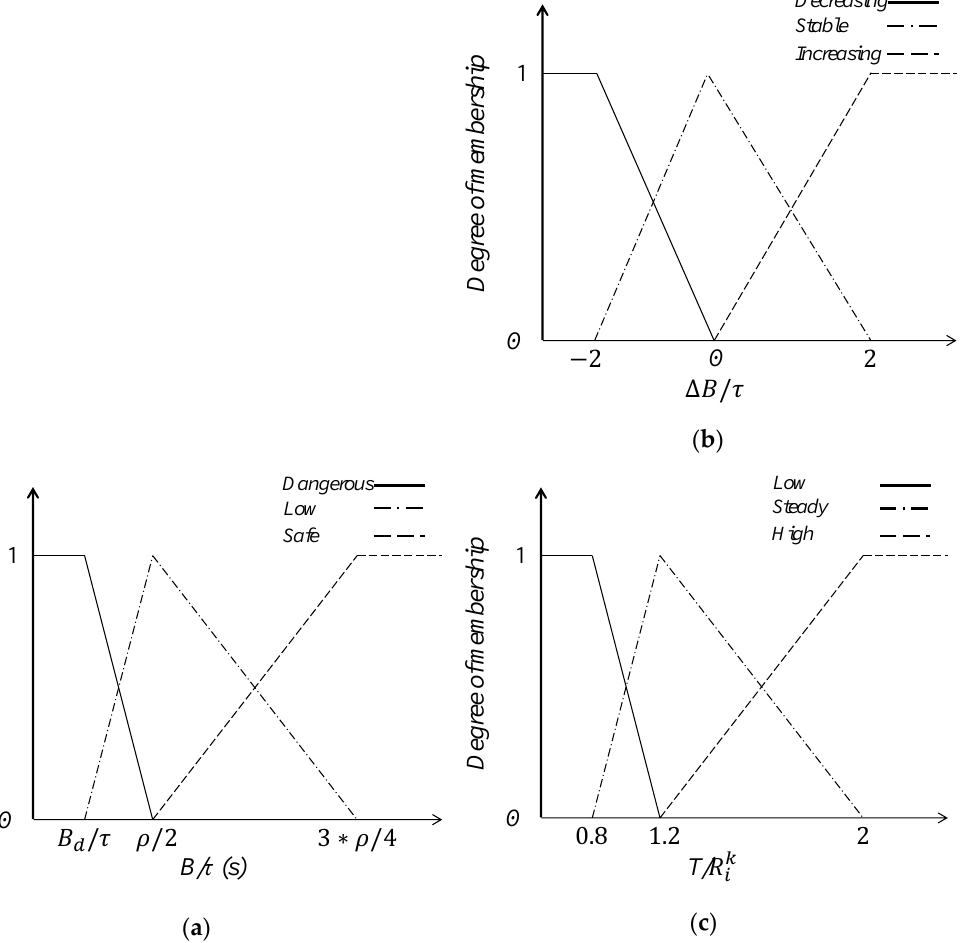
Figure 4. Membership functions for ( a ) the ratio of buffer level to segment duration, B/τ ; ( b ) the ratio of ∆ B to segment duration, ∆B/τ ; and ( c ) the ratio of throughput to the selected video rate, T/ 𝑅 𝑖𝑘 .